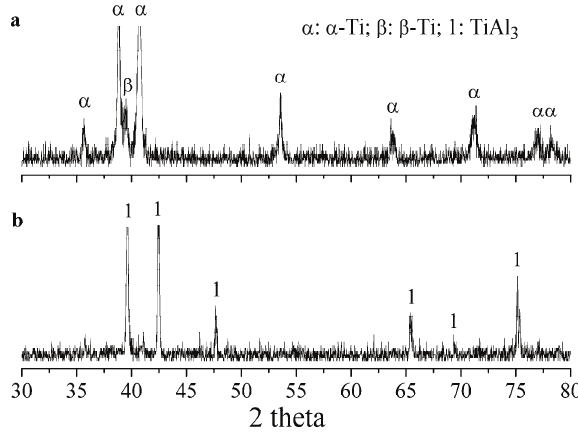
Figure 1. Micrograph of cross-section of the TA15 alloy after hot-dip aluminizing.